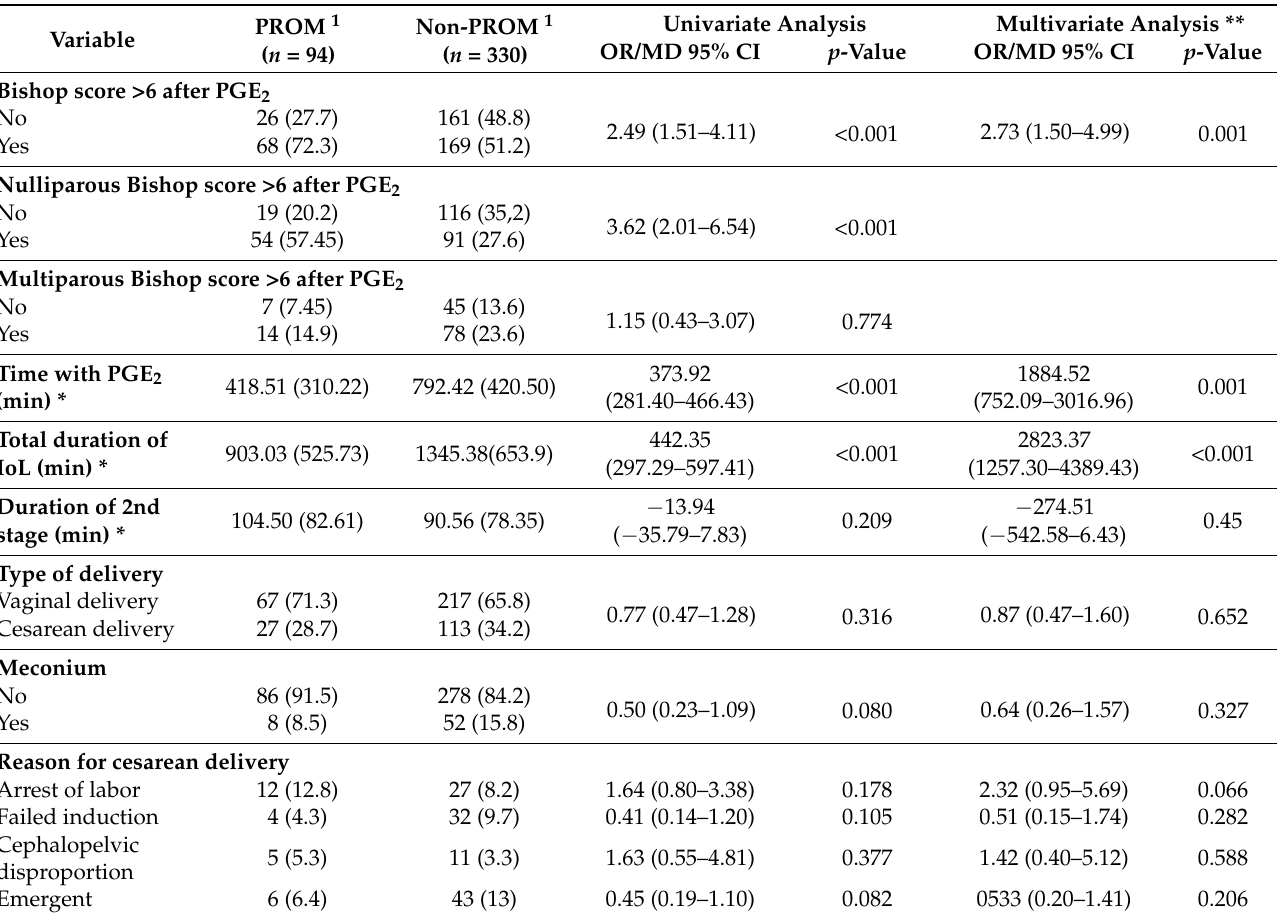
Table 2. Obstetric outcomes in the study population according to